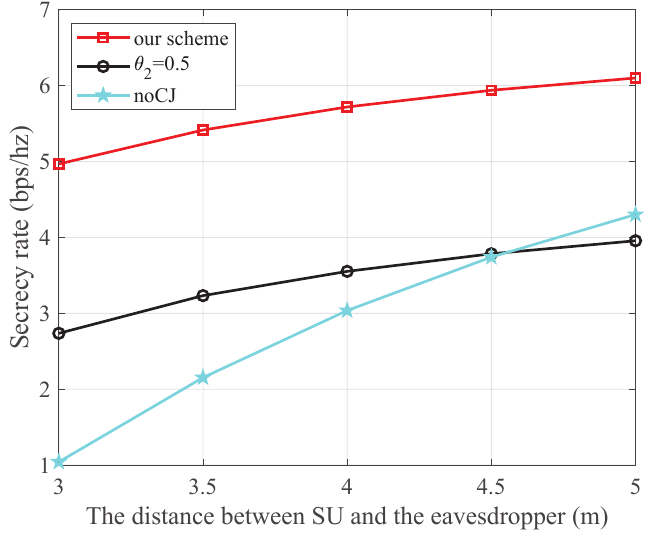
Figure 10. The secrecy rate versus the distance between SU and the